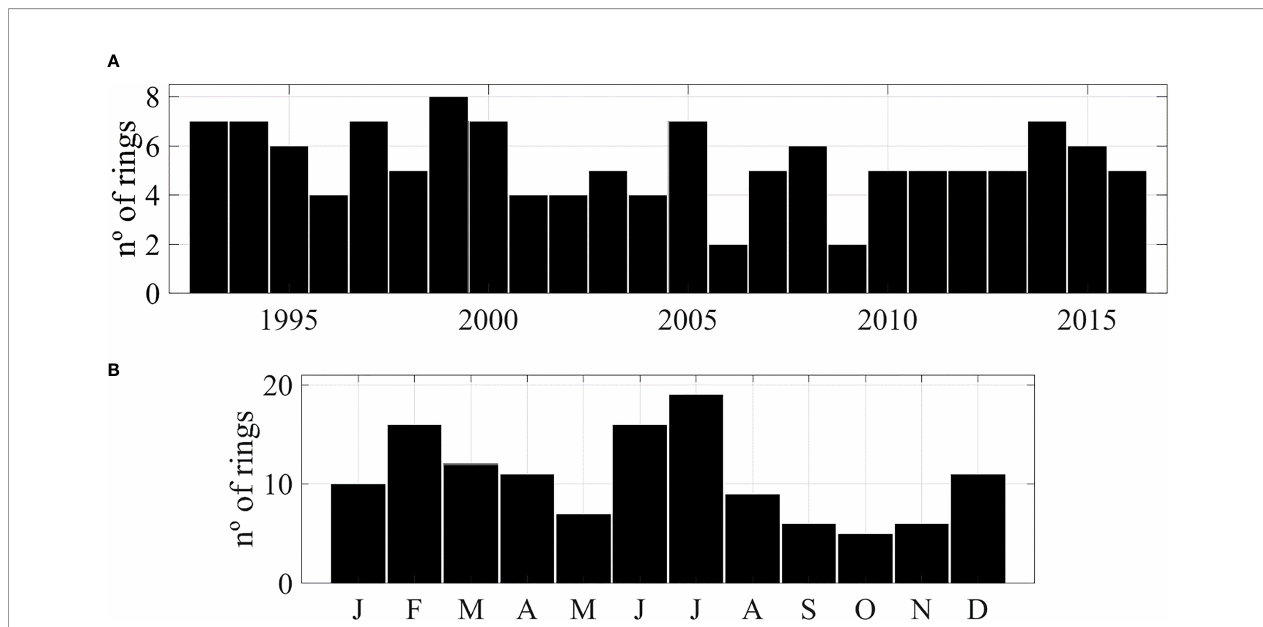
FIGURE 4 | Total number of NBC rings identi fi ed in the META dataset: (A) for each year, from 1993 to 2016; and (B) for each month, for the entire 24-year period. The annual and monthly values were calculated based on the date when each ring was identi fi ed for the fi rst time within the ring formation